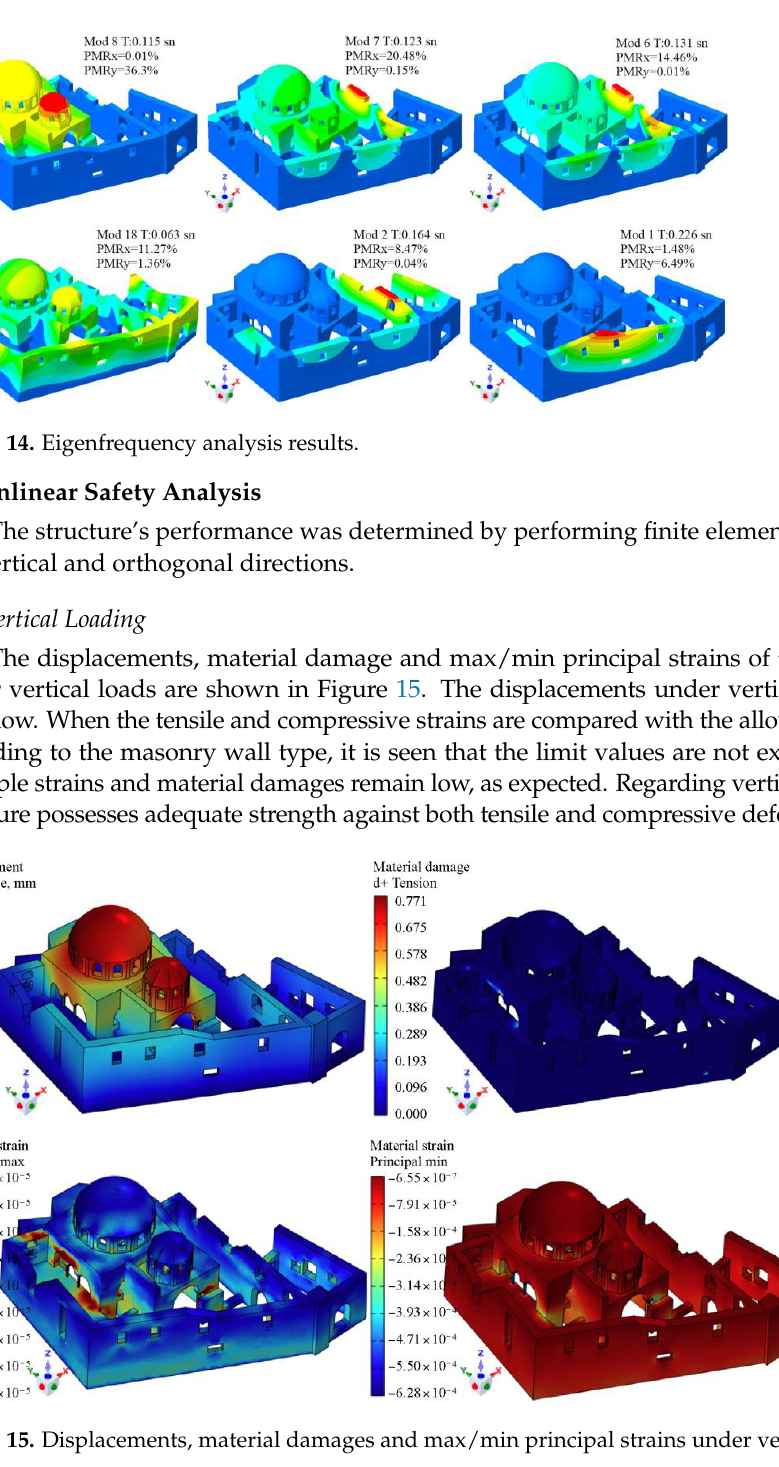
Figure 13. Tensile and compressive uniaxial law of Damage TC3D material model [55].